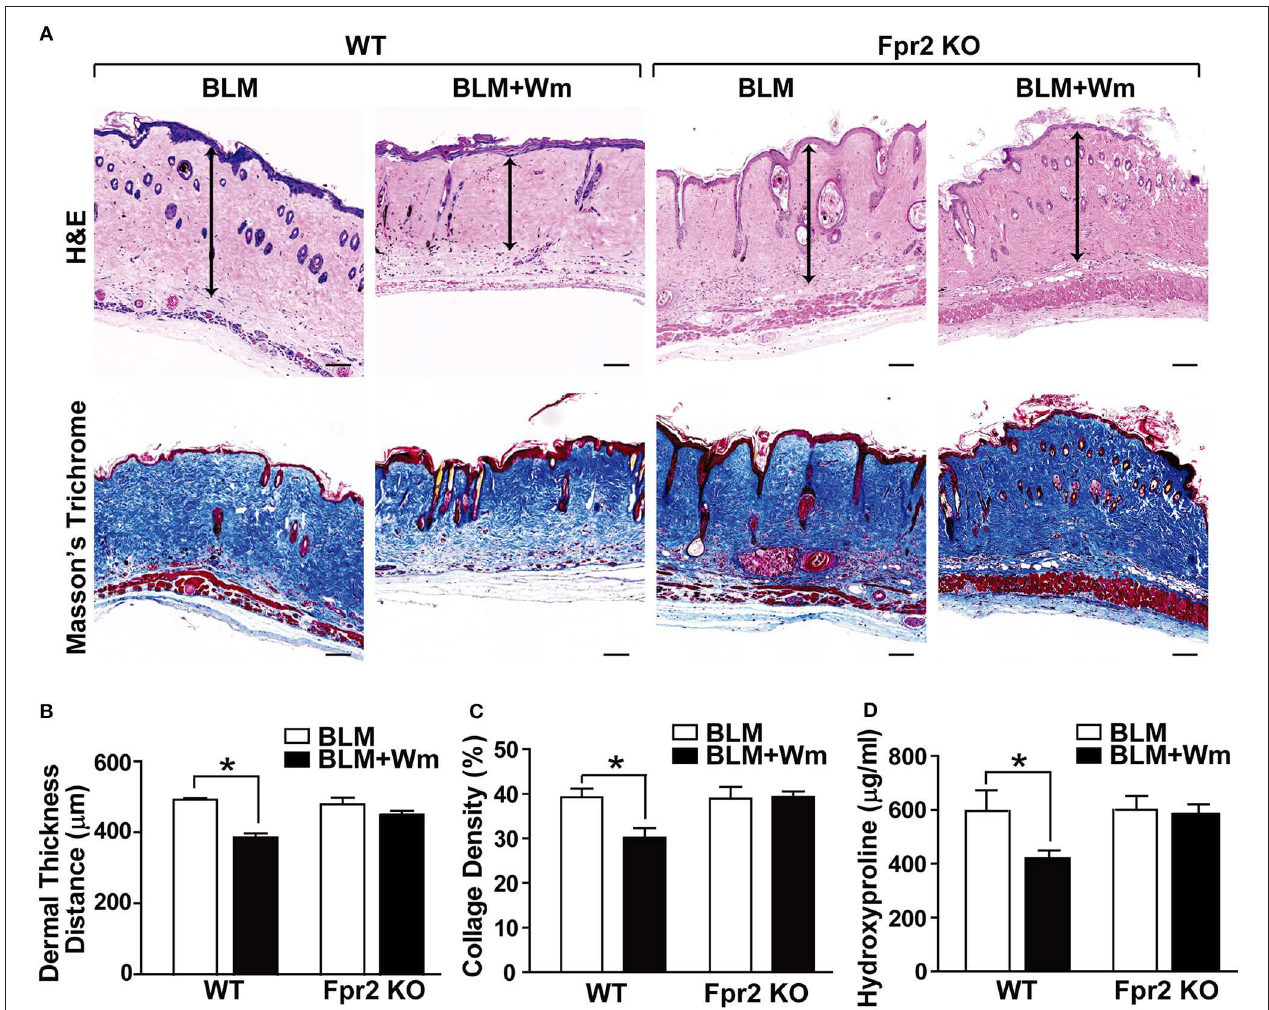
FIGURE 5 | The role of Fpr2 in WKYMVm-induced alleviation of dermal fibrosis in scleroderma. (A) Wild type and Fpr2 KO mice were daily injected with BLM for 3 weeks, followed by co-administration of BLM with or without 1 µ M Wm for additional 3 weeks. Skin specimens of BLM-induced scleroderma mice were stained with H&E and Masson’s trichrome stain. Scale bar = 100 µ m. Dermal thickness (B) and collagen density (C) were quantified from the H&E and Masson’s Trichrome data, respectively. (D) The levels of hydroxyproline content in skin specimens were determined by using a hydroxyproline assay kit. Data are shown as the mean ± SD ( n = 8). * p <